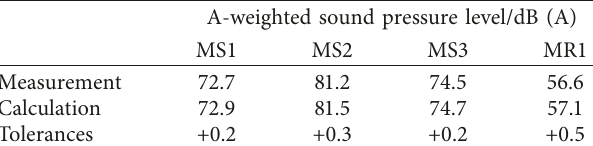
Figure 15: Simulation results verification. Table 4: Simulation results verification.